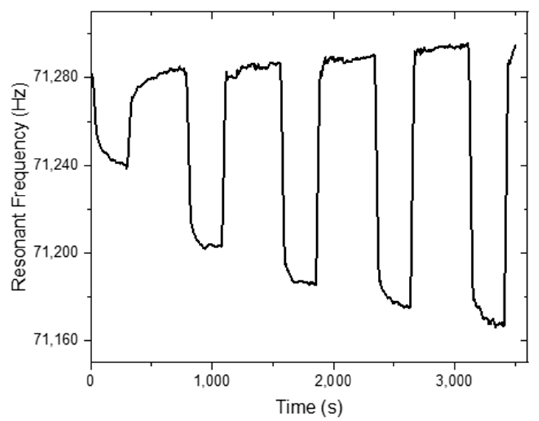
Figure 7. The static humidity response of the MES-1 for 41%, 58%, 63%, 69%, and 73% RH cycles, respectively.